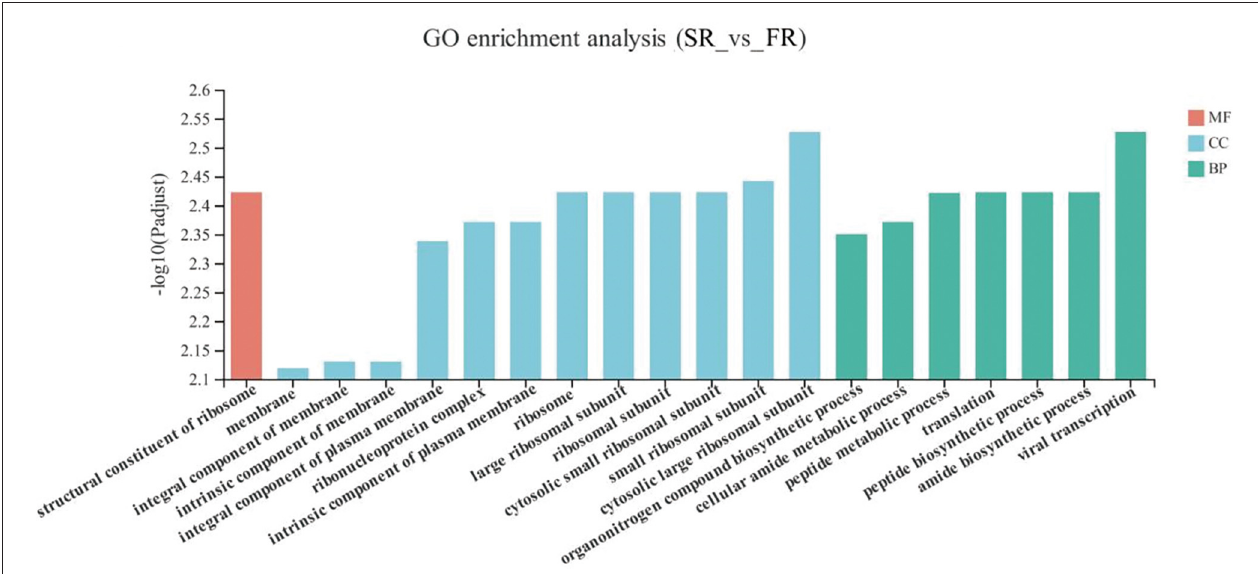
FIGURE 4 | GO terms of differentially expressed genes (DEGs) between SR and FR groups. SR, slow-growing dual-purpose chickens feed restriction; FR, fast-growing broilers feed restriction.